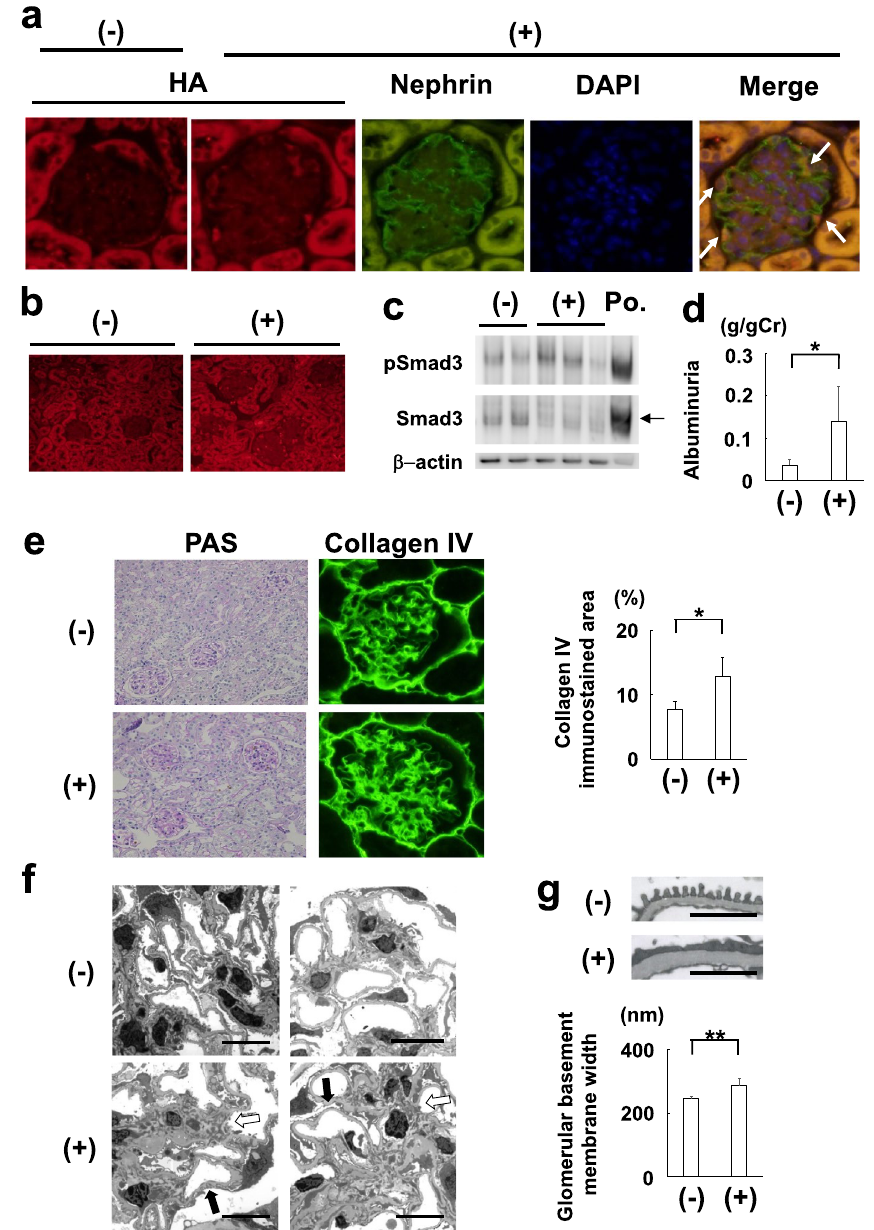
Figure 1. Characterization and pathological changes in podocyte-specific TGF-β1 overexpression mice. ( a ) TGF-β1 was expressed in podocytes. HA-tag was conjugated with bioactive porcine TGF-β1 in PodCre(+) TGF mice. HA-tag merged with nephrin (podocyte marker). ( b ) Diffuse expression of HA-tag conjugated TGF-β1 was observed in the kidney of PodCre(+) TGF mice. ( c ) Representative pictures of western blot analysis of glomeruli protein. The bands immunoblotted with Smad3 increased in size when phosphorylated (arrow). Smad3 was phosphorylated in glomeruli in PodCre(+) TGF mice. ( d ) Urine albumin excretion was significantly increased in PodCre(+) TGF mice. (N = 6 in control mice, N = 8 in PodCre(+) TGF mice). * P < 0.01 (Mann–Whitney’s U test). ( e ) Representative pictures of periodic acid-Schiff (PAS) stain and collagen IV immunohistochemistry in PodCre(+) TGF mice. PodCre(+) TGF mice showed a significant increase in collagen IV immunostained area (N = 6 in control mice, N = 8 in PodCre(+) TGF mice). * P < 0.01 (t-test). ( f ) Representative pictures of electron microscopy. PodCre(+) TGF mice showed mesangial expansion (white arrow) and diffuse foot process effacement (black arrow). Scale bar: 10 µm. ( g ) Representative pictures of glomerular basement membrane by using electron microscopy and quantitative evaluation of glomerular basement membrane width. PodCre(+) TGF mice showed a significant thickening of glomerular basement membrane (N = 3 in control mice, N = 4 in PodCre(+) TGF mice). Scale bar: 2 µm. ** P < 0.05 (t-test). (−): control mice. (+): Podocyte-specific TGF-β1 overexpression mice (PodCre(+) TGF mice). Po.: positive control. pSmad3: phosphorylated Smad3. n.s.: not